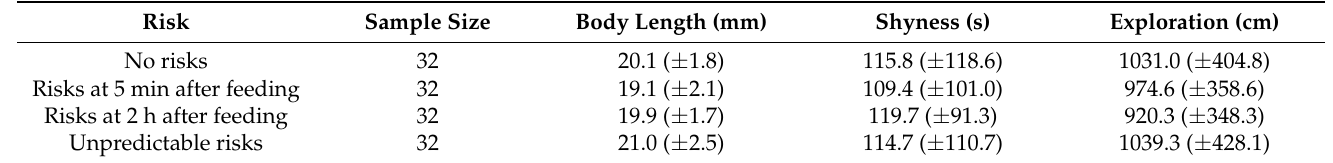
Table 3. Means of body length and behavioral traits ( ± standard deviation, SD) of female mosquitofish reared under different risk